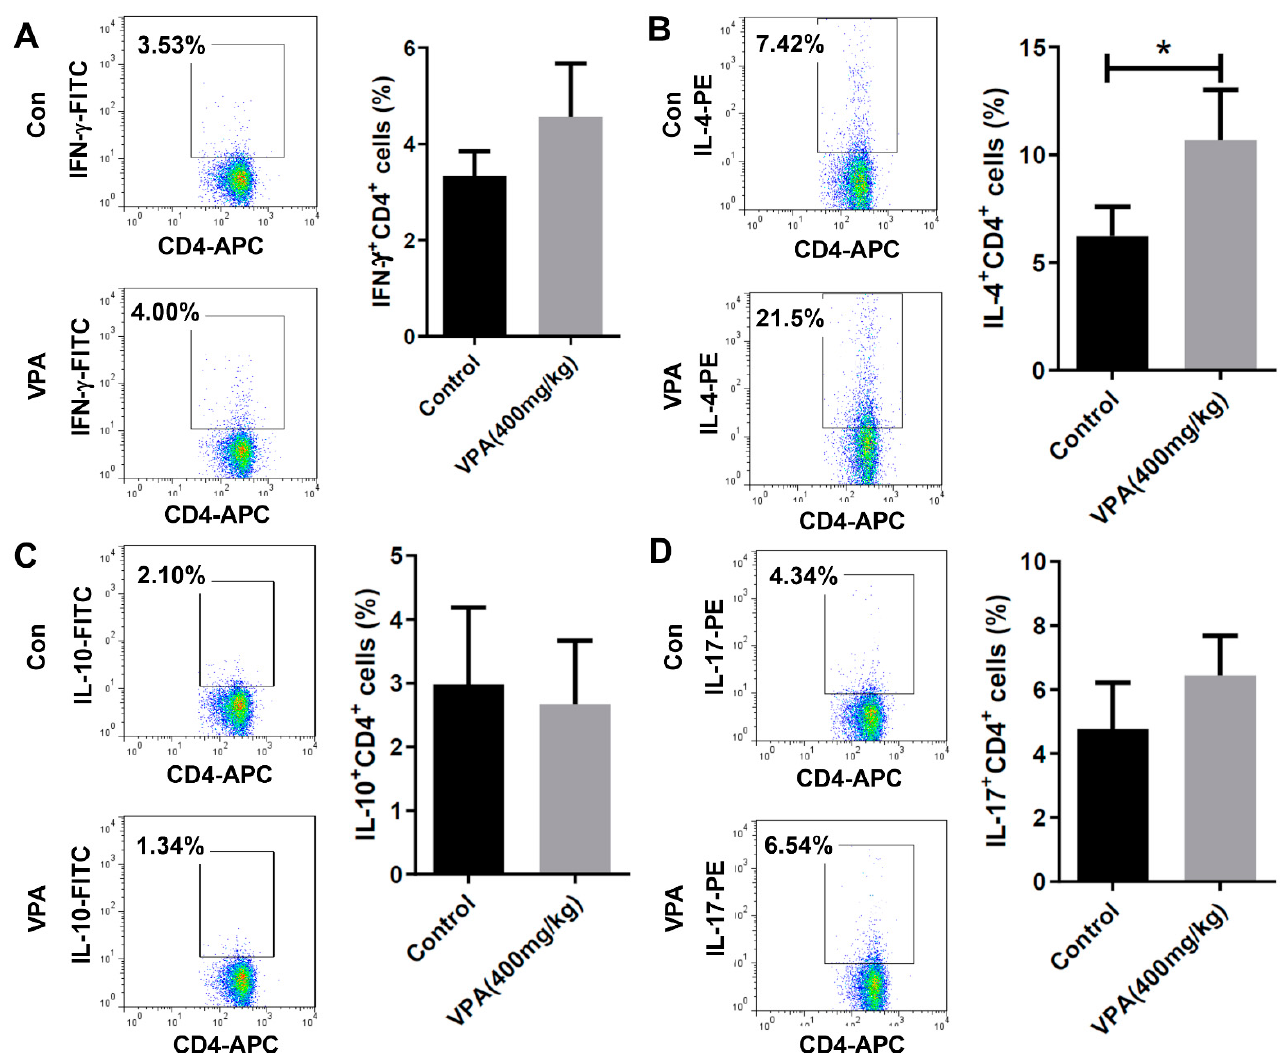
Figure 5. The effect of VPA treatment in the subsets of helper T cells in the spleen of NOD mouse after islet transplantation. The population of Th1, Th2, IL-10-producing and Th17 CD4 T cells in the PBS-treated or VPA-treated NOD recipients was analyzed by flow cytometry. ( A ) No significant difference in the population of Th1 cells. ( B ) A significant increase was observed in the percentage of Th2 (IL-4-producing CD4 T) cells in the VPA-treated recipients. No significant difference in the percentage of ( C ) IL-10-producing CD4 T cells and ( D ) Th17 (IL-17-producing CD4 T) cells. Data are expressed as the mean ± SEM (* = p < 0.05).